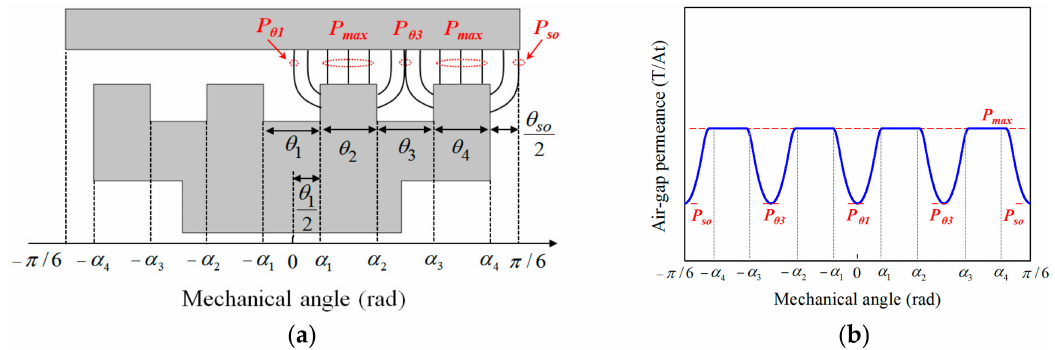
Figure 3. The shape of the flux modulation poles (FMPs) formed on the tooth and the resulting permeance in the air-gap. ( a ) Design variables for the FMP shape; ( b ) Air-gap permeance